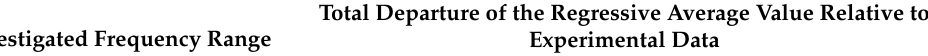
Table 3. Deviations among the theoretical predictions, simulation results, and experimental